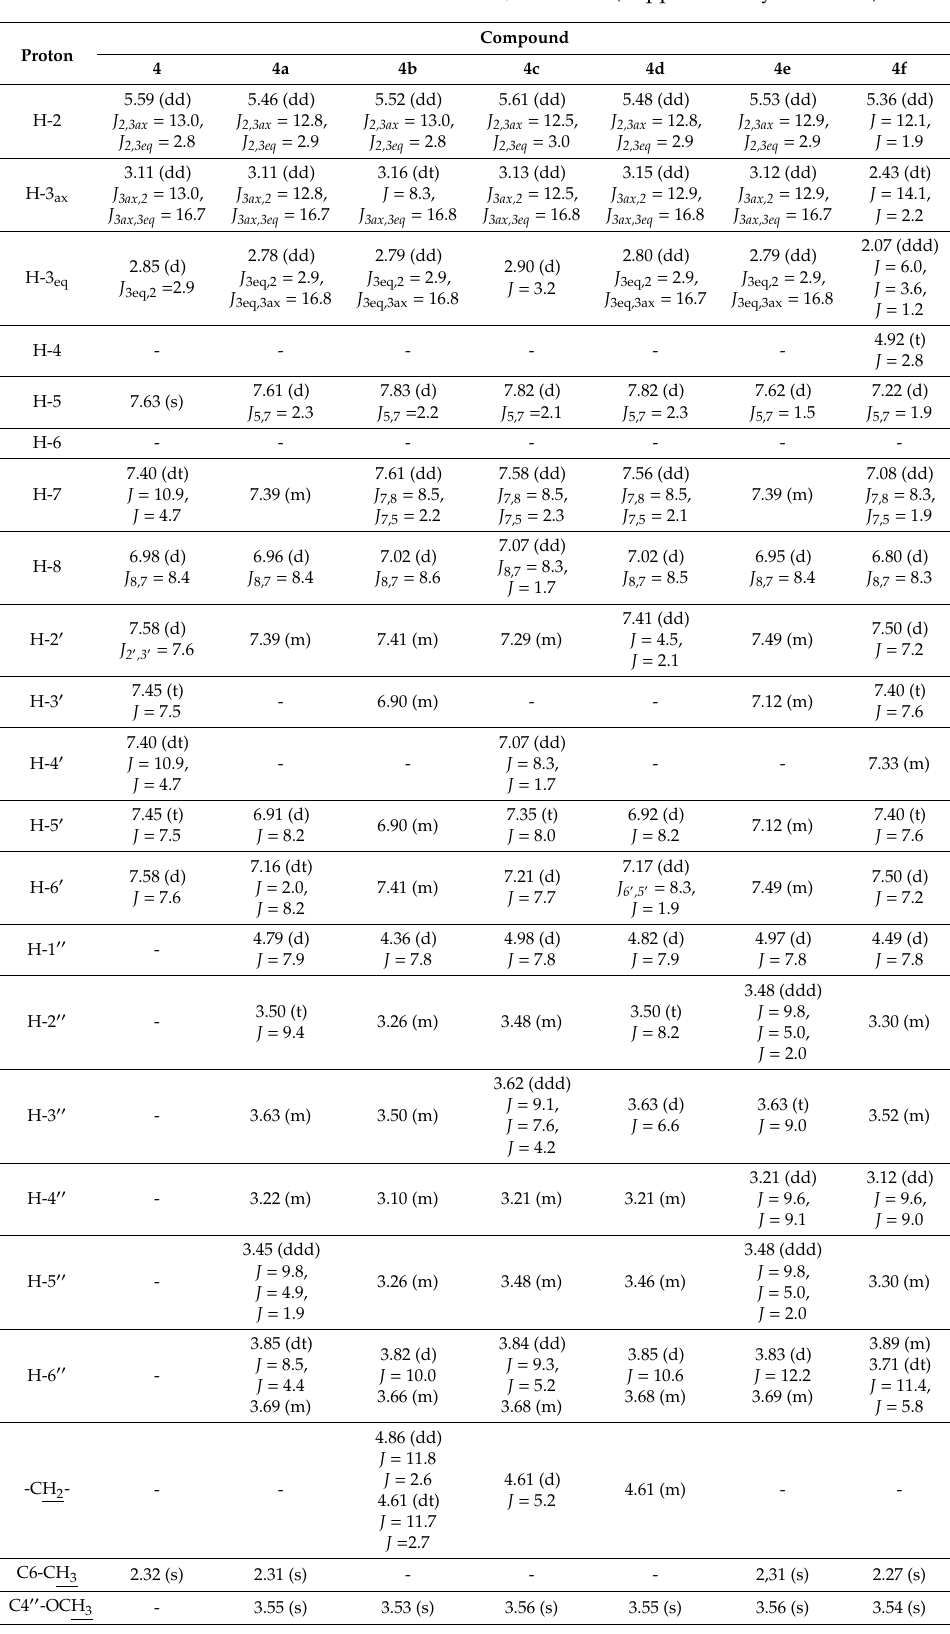
Table 3. 1 H-NMR chemical shifts δ (ppm) and coupling constants J (Hz) of 6-methylflavanone ( 4 )